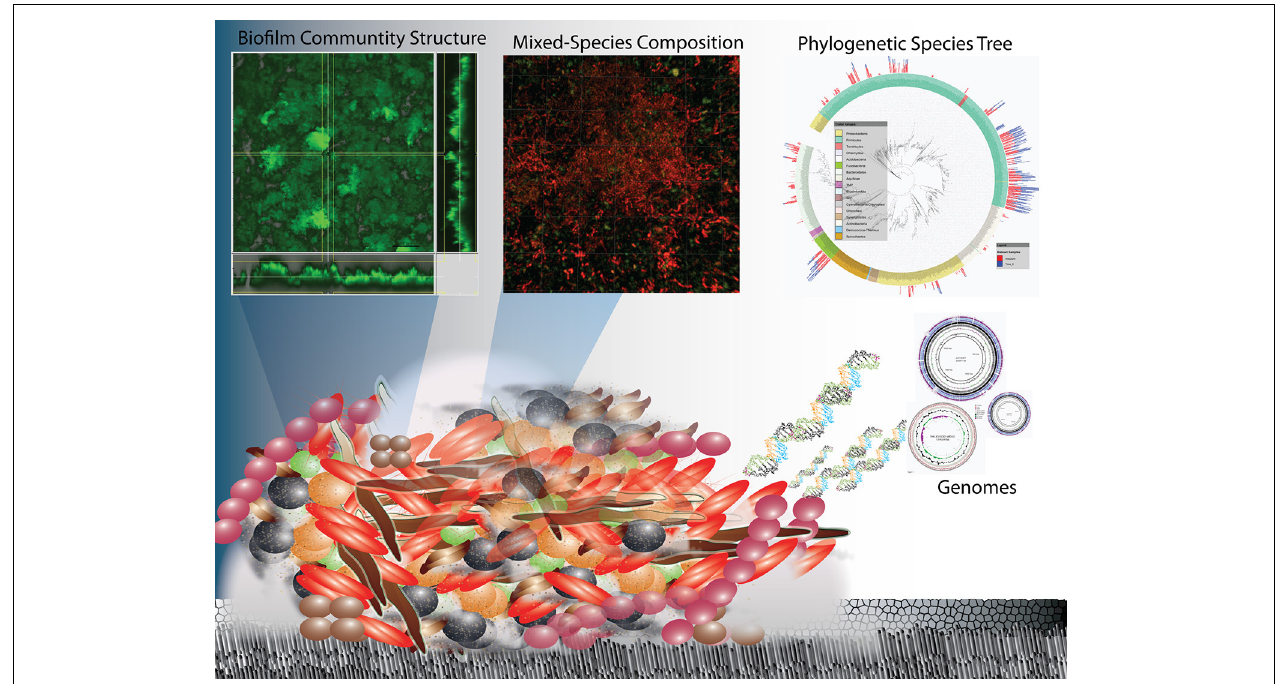
FIGURE 1 | Overview schematic representation of the structure and complexity of oral biofilms on enamel surfaces in terms of physical heterogeneity and species diversity. Research on oral biofilms has encompassed biofilm structure and function at the